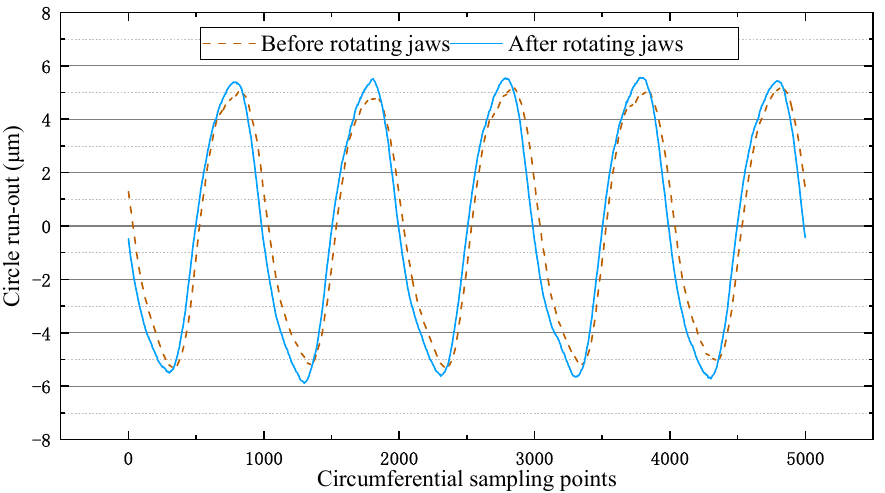
Figure 9. Graph of rotating jaws experimental results.